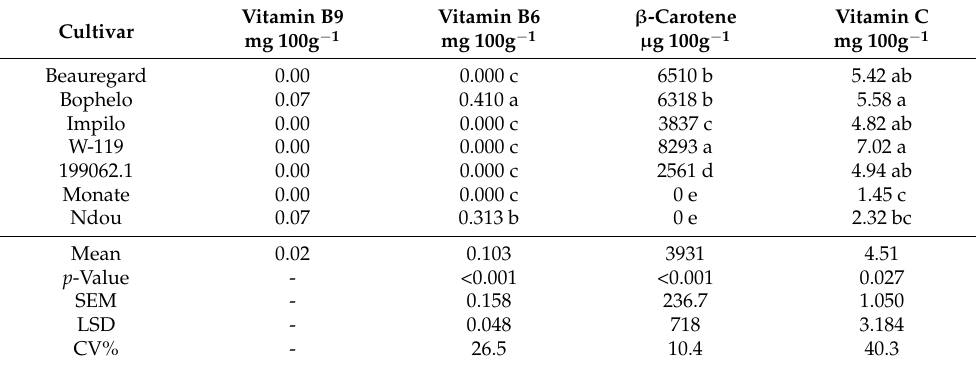
Table 3. Vitamins B9, B6, and C and trans β -carotene content of sweet potato cultivars with varying flesh